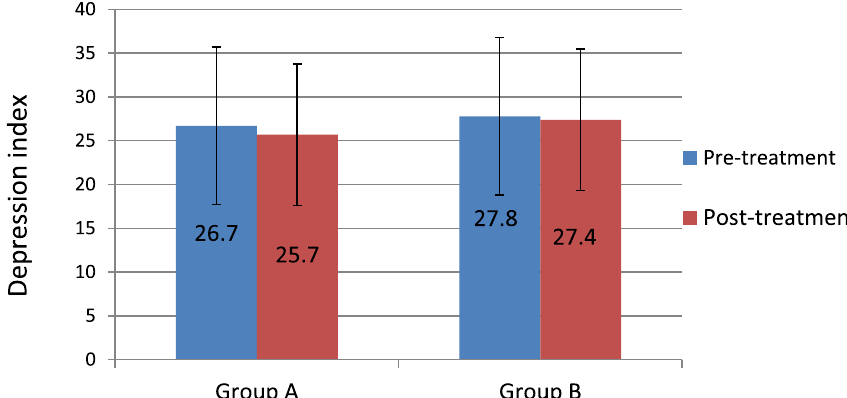
Fig. 5 Mean values of depression index pre- and post-treatment within each